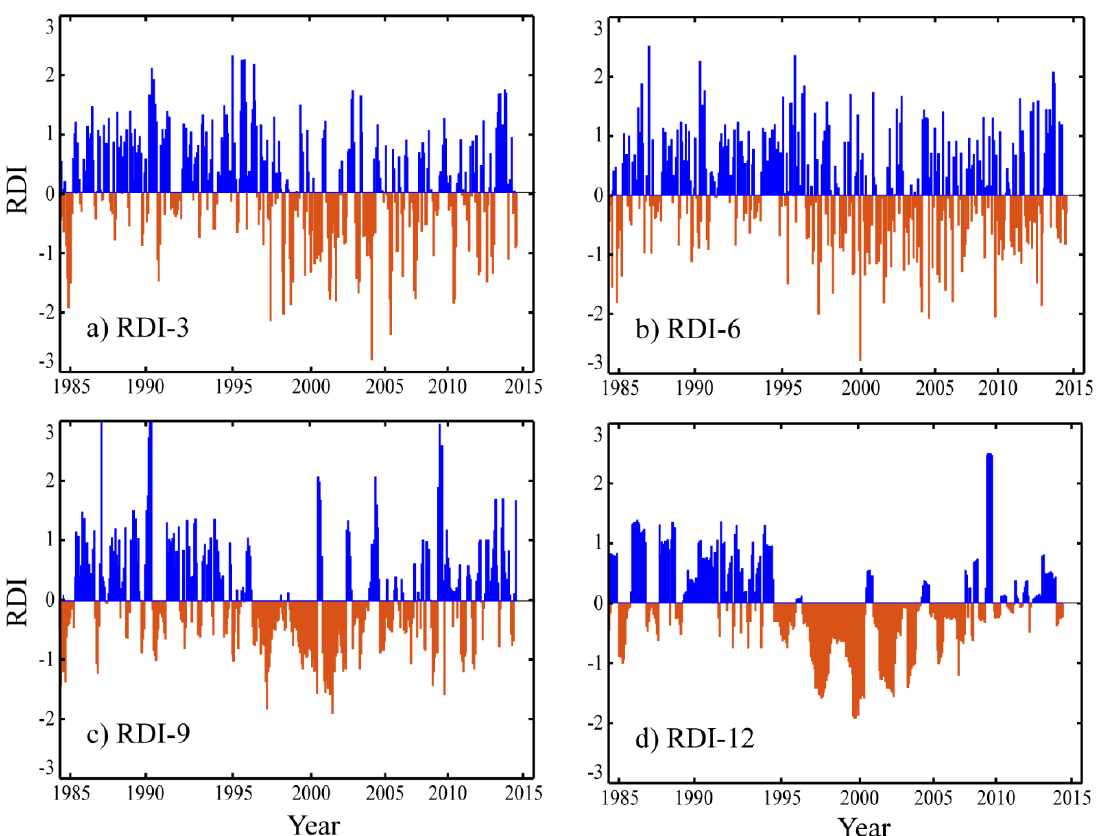
Figure 4. Temporal evolution of the average RDI of the nine meteorological stations in the accumulation periods of ( a ) 3, ( b ) 6, ( c ) 9, and ( d ) 12 months.